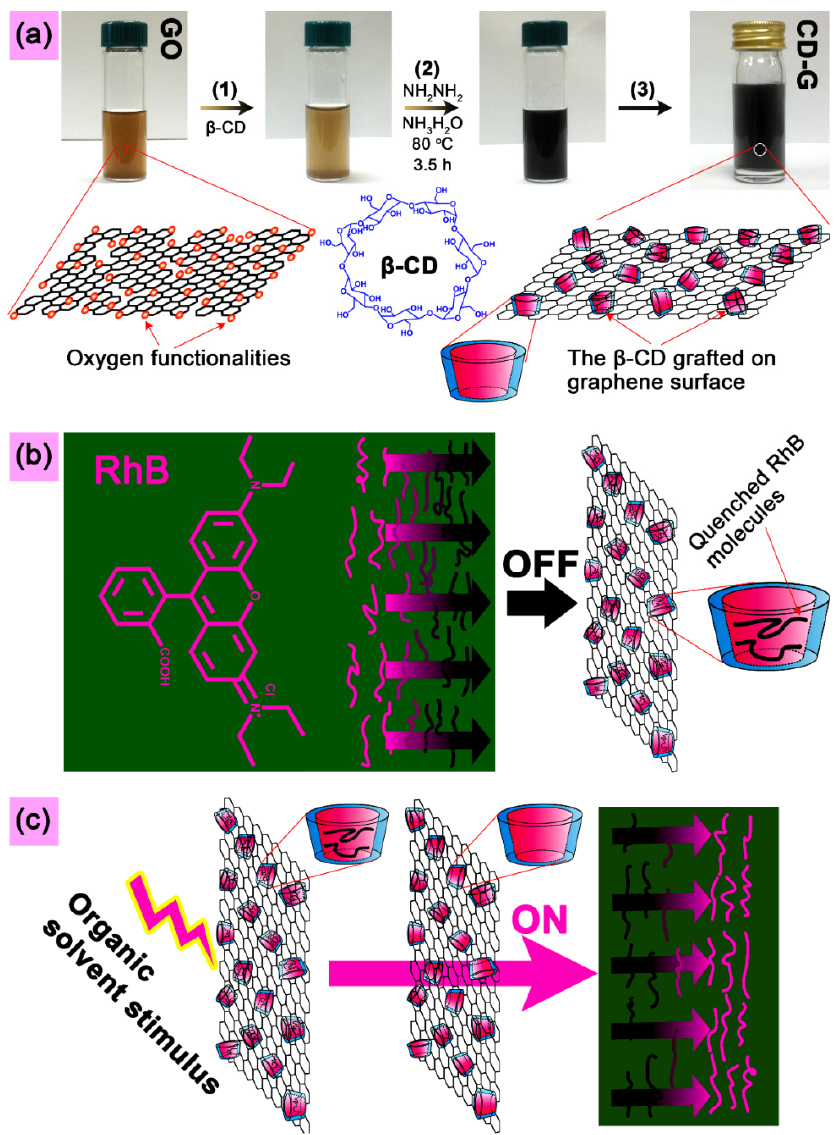
Figure 1. ( a ) Digital images and schematic illustrations showing the primary experimental procedure for fabrication of CD-G, as well as the structural models of GO, β -CD and CD-G. ( b ) Schematic diagram used to explain the quenching of the RhB fluorescence by CD-G in molecular scale, as well as showing the complex structure of CD-G and RhB. ( c ) Schematic presentation of the fluorescence switch-on process, along with molecular scale